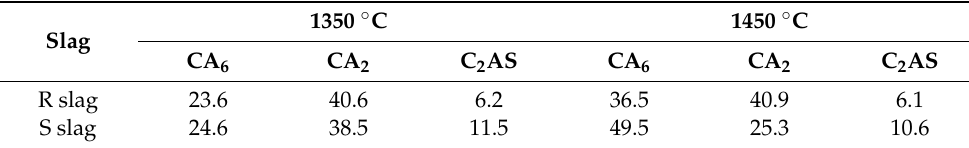
Table 7. The amounts of gehlenite, C 2 AS, in samples corroded by slag S (Al-1-2 and Al-2-2) were at a comparable levels of 11.5% and 10.6% for 1350 ◦ C and 1450 ◦ C, respectively. In slag R, which results from two times lower SiO 2 content in the original slag (5% SiO 2 ). Table 7. Rietveld analysis of the test